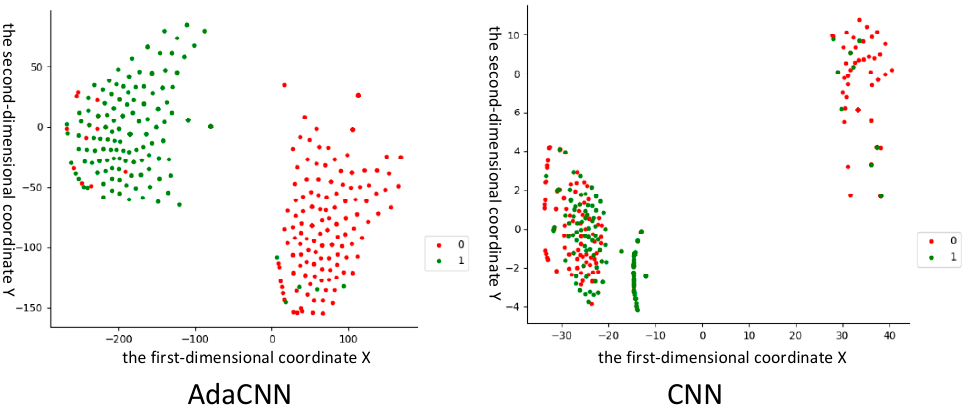
Figure 8. Comparison of visualization effects of the second convolutional layer when fault diagnosis knowledge is transferred between different locations.